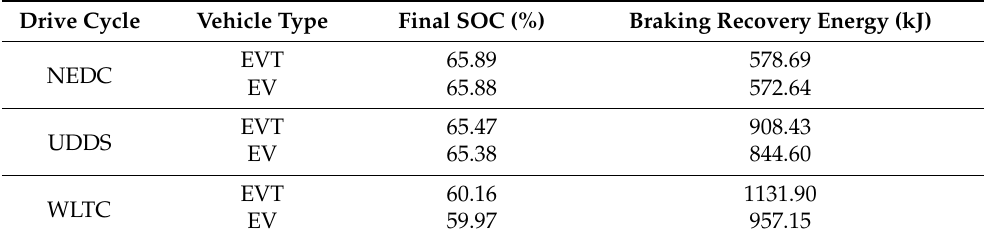
Figure 15. Battery SOC curves in three driving cycles: ( a ) NEDC driving cycle; ( b ) UDDS driving cycle; ( c ) WLTC driving cycle. Table 2. The final value of battery SOC and braking energy